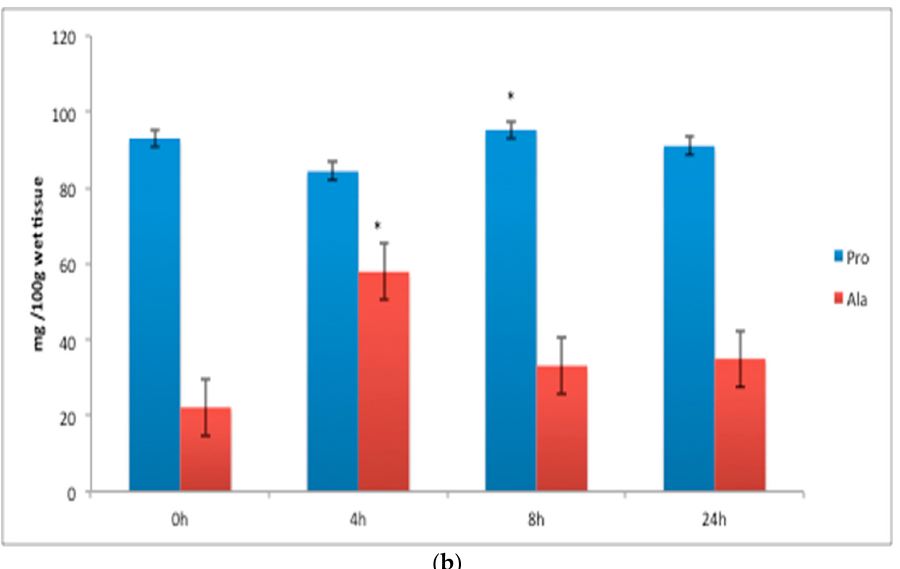
Figure 3. Non-essential free amino acid (FAA) concentration (mg/100 g wet tissue): ( a ) white muscle and ( b ) liver before (t = 0 h) and after feeding (4 h, 8 h, 24 h) with the laboratory experimental diet. Data are expressed as mean ± SE, n = 9 fish per time point. The asterisk above bars indicates that there are statistically significant differences among the time after feeding ( p < 0.05).